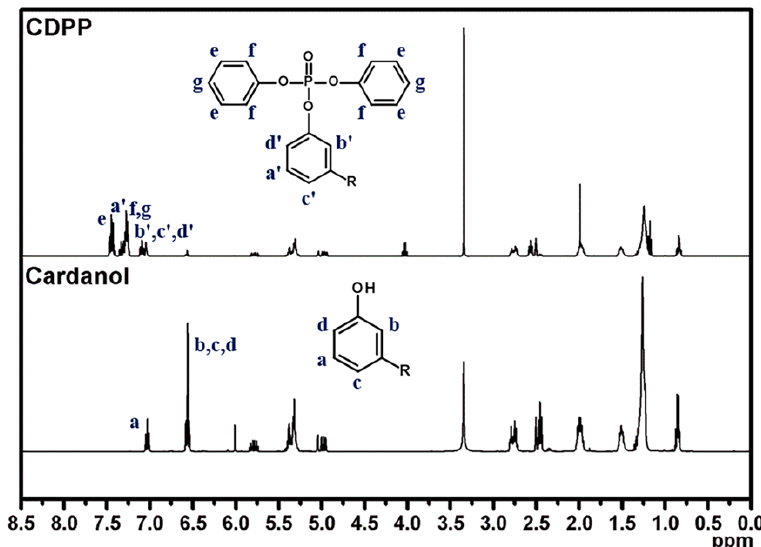
1 H NMR spectra of cardanol and CDPP. Figure 2.